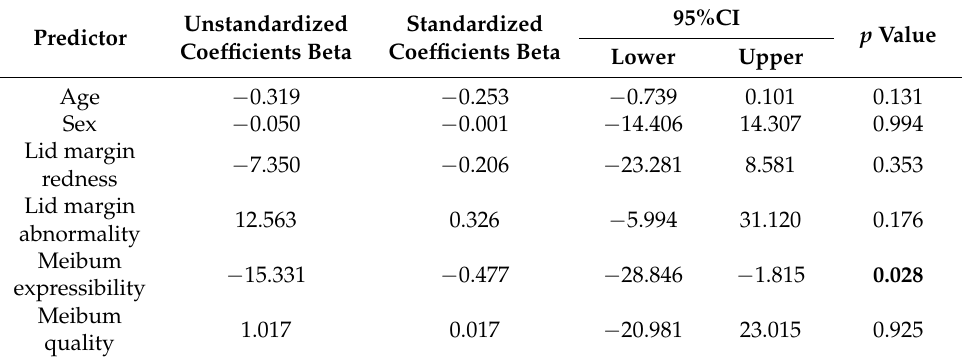
Table 4. Results of a multiple linear regression analysis examining the impact of relative variables at baseline on the changes in ocular surface disease